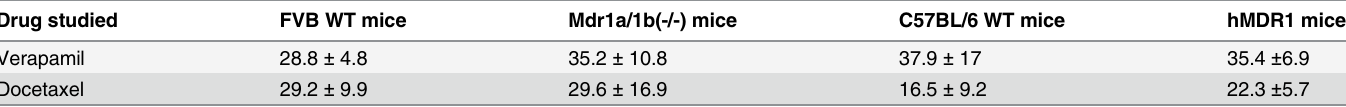
Table 2. Cyclosporine A concentrations ( μ g/ml) in blood of the different groups of mice. The first column represents the drug studied in the presence of cyclosporine